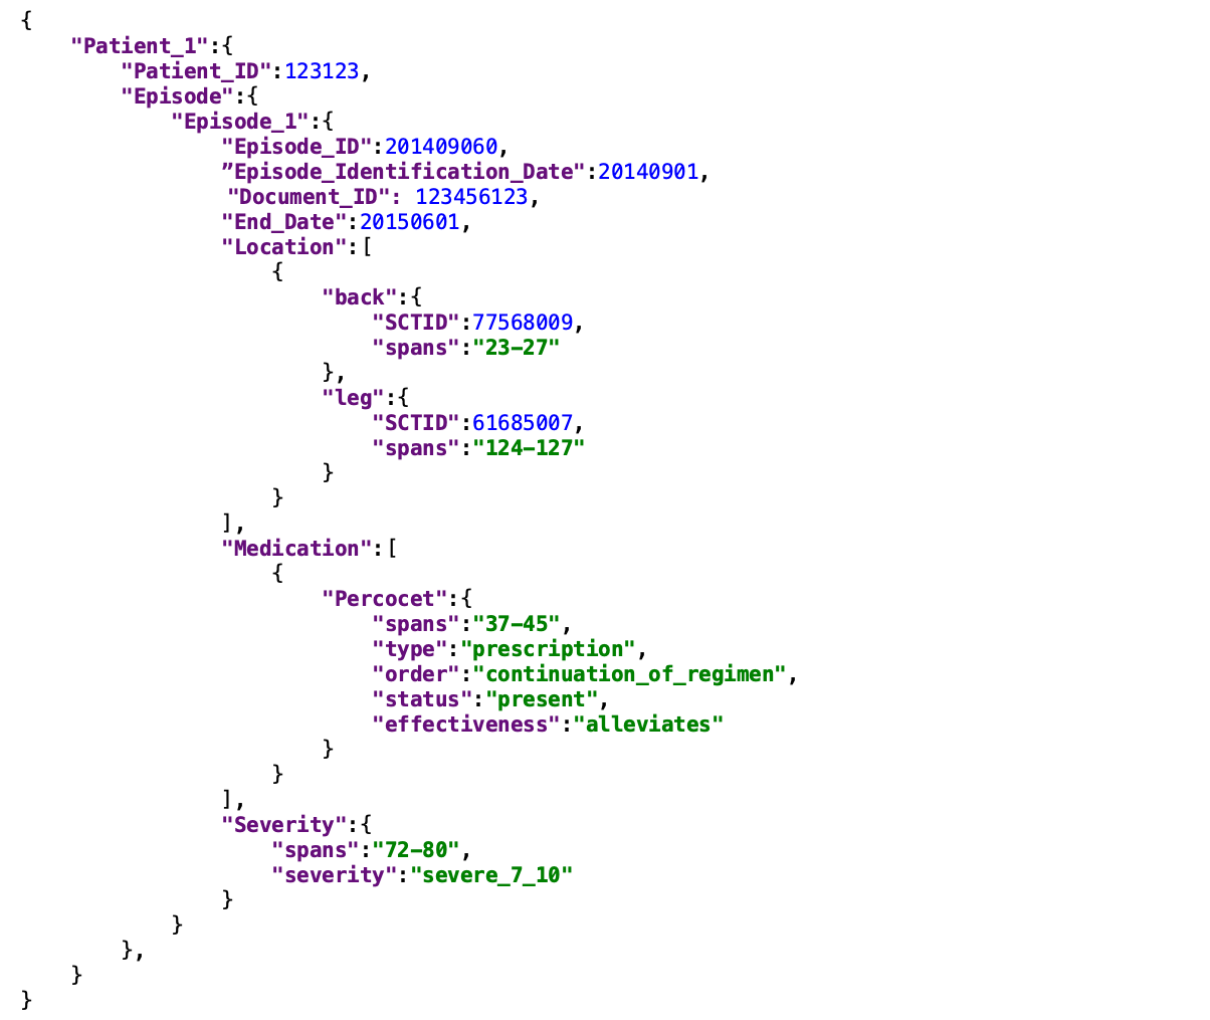
Figure 6. Illustration of an annotated episode exported into JavaScript Object Notation (JSON) format. Here, the mock-up patient had one episode of severe chronic pain in the back and the leg and received Percocet, which alleviated the pain. SCTID: SNOMED CT (Systematized Nomenclature Of Medicine–Clinical Terms)